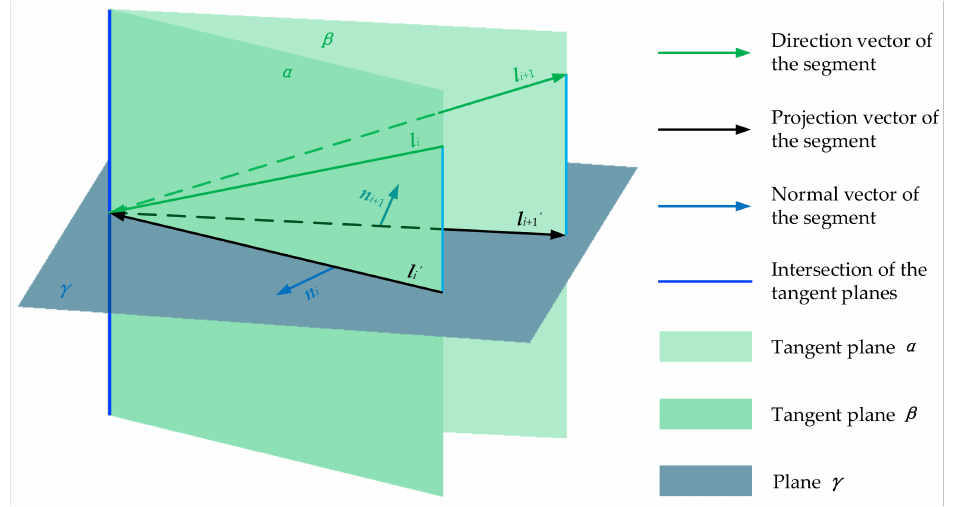
Figure 6. Reorient normal directions of a single contour